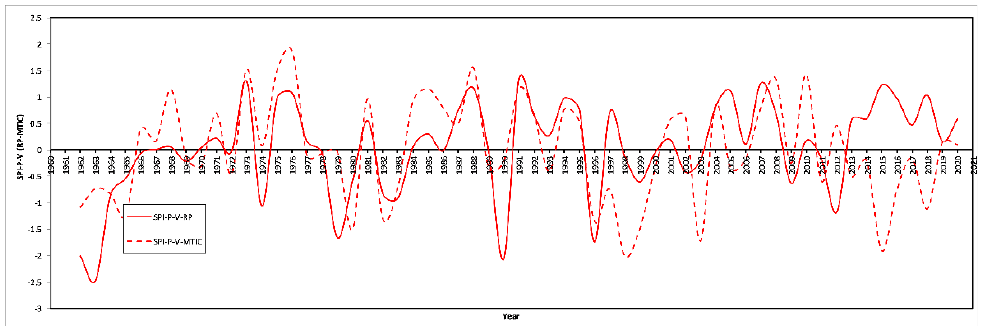
Figure 2. PDI-6 values for the spring–summer cycle in the Rincón del Porvenir (RP) and Mexquitic (MTIC) stations. Source: Author’s elaboration based on CONAGUA (2020). SPI-P-V-RP = Rincon del Porvenir Station. SPI-P-V-RP = Mexquitic Station.